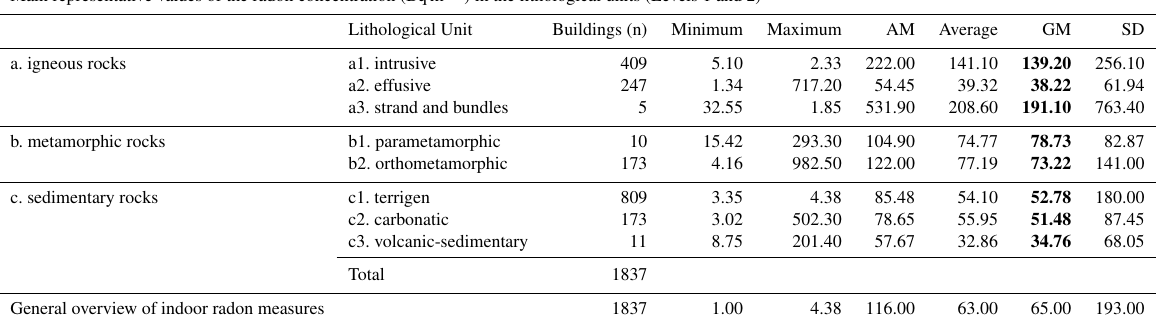
Table 4. Main representative values of radon concentrations in the lithological units and a general overview of indoor radon measures detected during the Sardinia Regional Agency for Environmental Protection Radon Project.